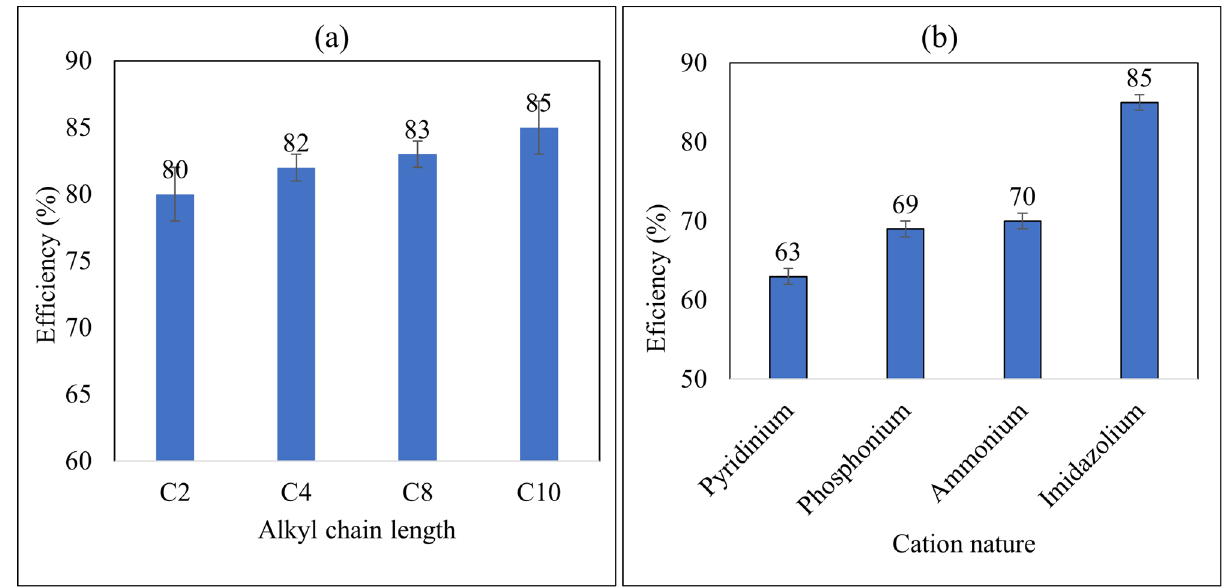
Figure 1. ( a ) Effect of alkyl chain length on the removal efficiency of oil from PW using different ILs at initial concentration = 500 mg/L, contact time = 5 min, phase ratio (IL:PW) = 1:5, and temperature = 25 °C, with σ = ±4.02 × 10 − 1 %, ( b ) Effect of cation nature on the removal efficiency of oil from PW using different ILs with the same anion at initial concentration = 500 mg/L, contact time = 5 min, phase ratio (IL:PW) = 1:5, and temperature = 25 °C, with σ = ±3.33 × 10 − 1 %.